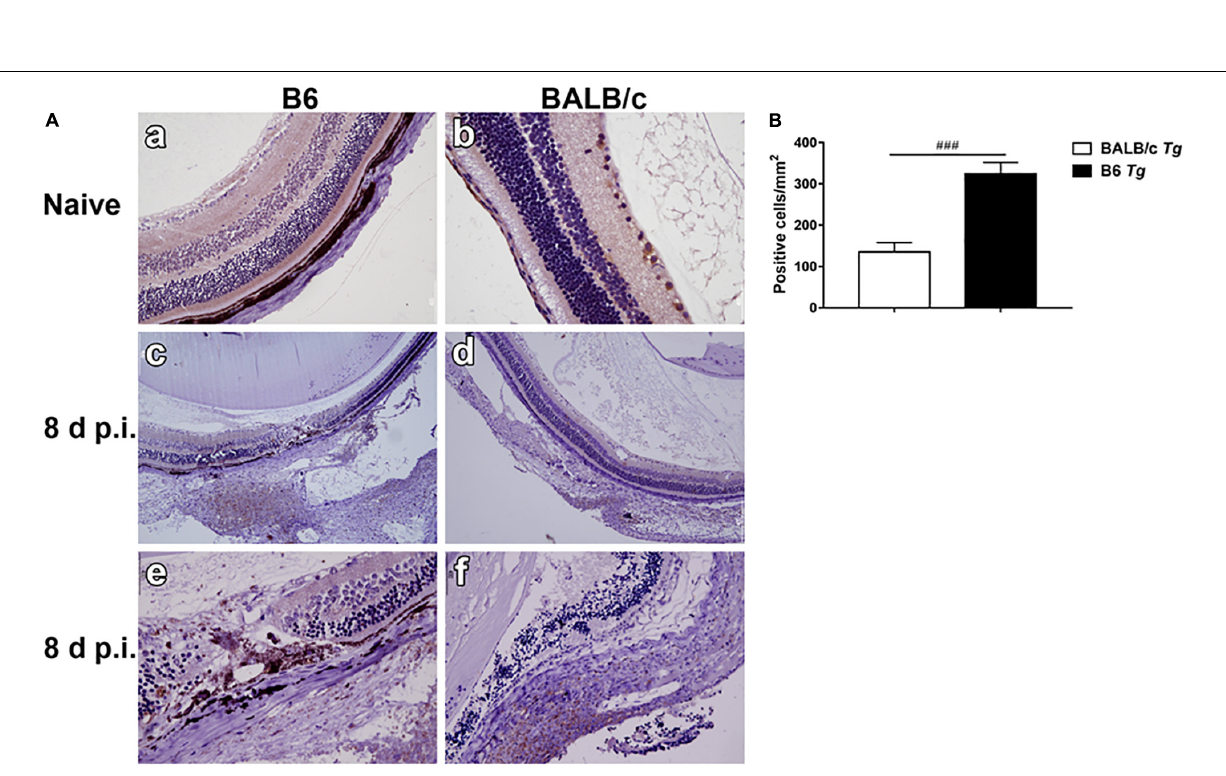
Frontiers in Microbiology |